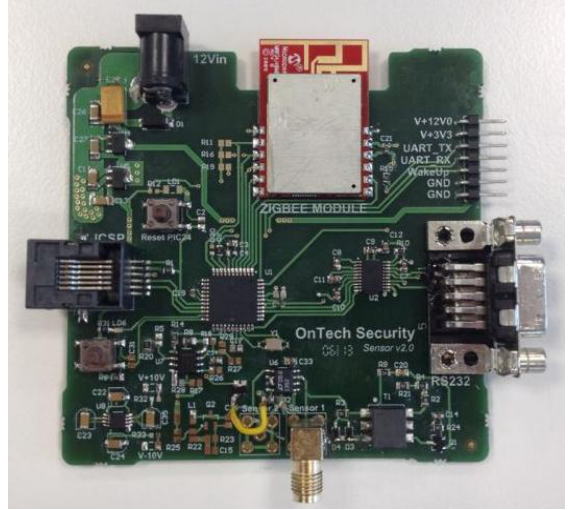
Figure 7. Photograph of the proposed detection system, composed by the capacitive sensor and the conditioning electronics.